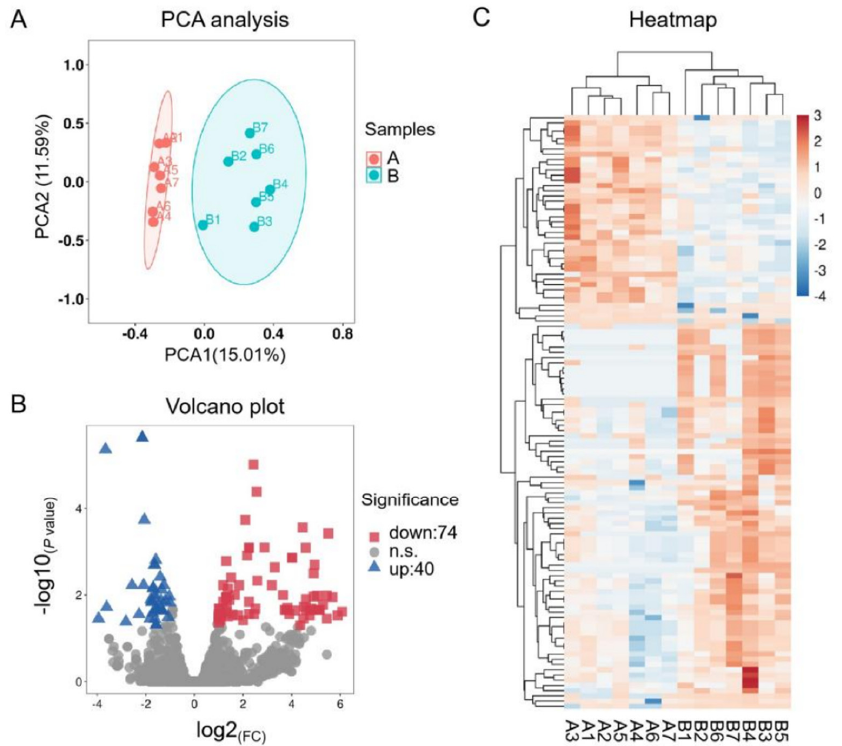
Figure 2. PCA and differentially expressed miRNAs (DEMs) before and after transportation. ( A ) PCA analysis of before and after transportation. ( B ) Volcano plot of DEMs between before and after transportation. ( C ) Heatmap of DEMs between before and after transportation.